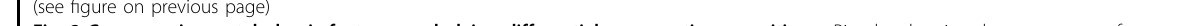
Fig. 2 Cross-species metabolomic features underlying differential regenerative capacities. a Pie plot showing the percentage of super- pathway for identi fi ed metabolites in AB, dASCs, NHP tissues and hMSCs. b PLS-DA analysis of metabolomic data generated in AB, dASCs, NHP tissues and hMSCs. c Bar plot showing the count of DPMPs identi fi ed in AB at DPA 11, dASCs, young NHP tissues, and young hMSCs. The percentages of DPMPs in each super-pathway were shown on the top of each bar graph. d The hierarchical clustering dendrogram showing the similarity of the metabolic pro fi le changes in AB at DPA 11, dASCs, young NHP tissues, and young hMSCs. e Heatmap showing the differential abundance (DA) for identi fi ed metabolites in each super-pathway in AB at DPA 11, dASCs, young NHP tissues, and young hMSCs. The color key from blue to amaranth indicates DA score from low to high for each super-pathway. f Heatmap showing the differential abundance for identi fi ed metabolites in each sub- pathway in AB at DPA 11, dASCs, young NHP tissues, and young hMSCs. Sub-pathways increased in at least seven tissues/cells with higher regenerative capacity were highlighted. The color key from blue to amaranth indicates DA score from low to high for each sub-pathway. g Network diagram showing the representative sub-pathways and relative abundance for DPMPs in each sub-pathway. The color of the edge from grey to amaranth indicates log 2 (fold change) from low to high. The node sizes are positively correlated to the edge counts for each